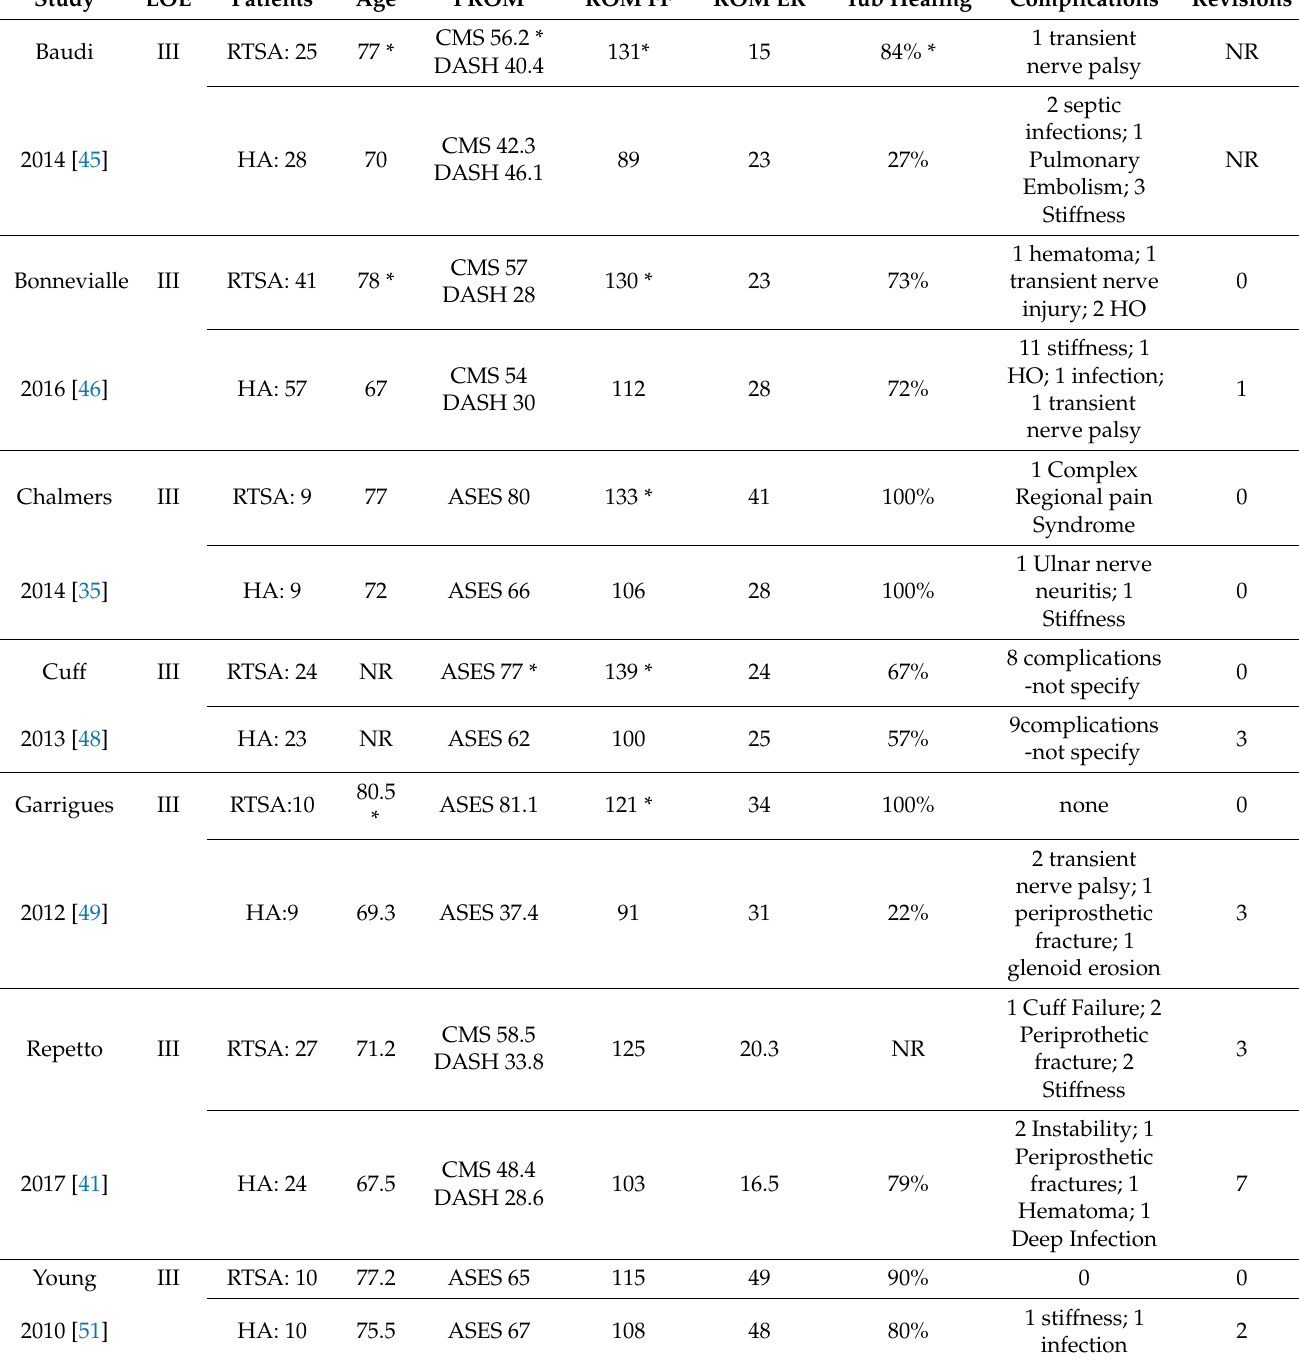
Table 3. Studies Comparing RTSA vs. HA for the treatment of Proximal Humerus